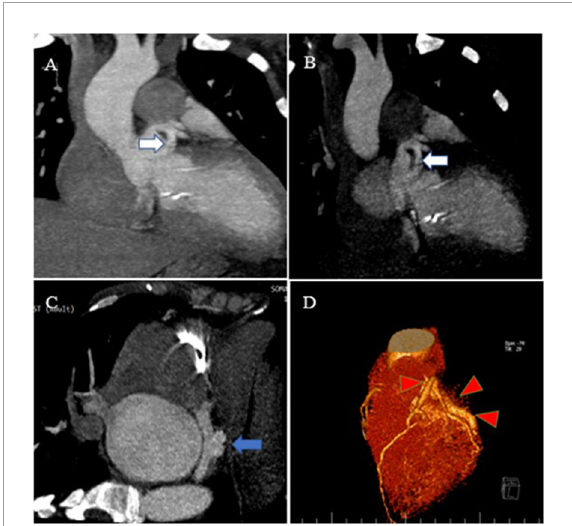
FIGURE1 Three-dimensional zoom mid esophageal echocardiography (A) shows dilated left circumflex artery (LCX; light blue arrow) and coronary sinus (CS), (B) tortuous, giant coronary fistula (white arrow), (C,D) mid esophageal full volume illustrating the same findings.